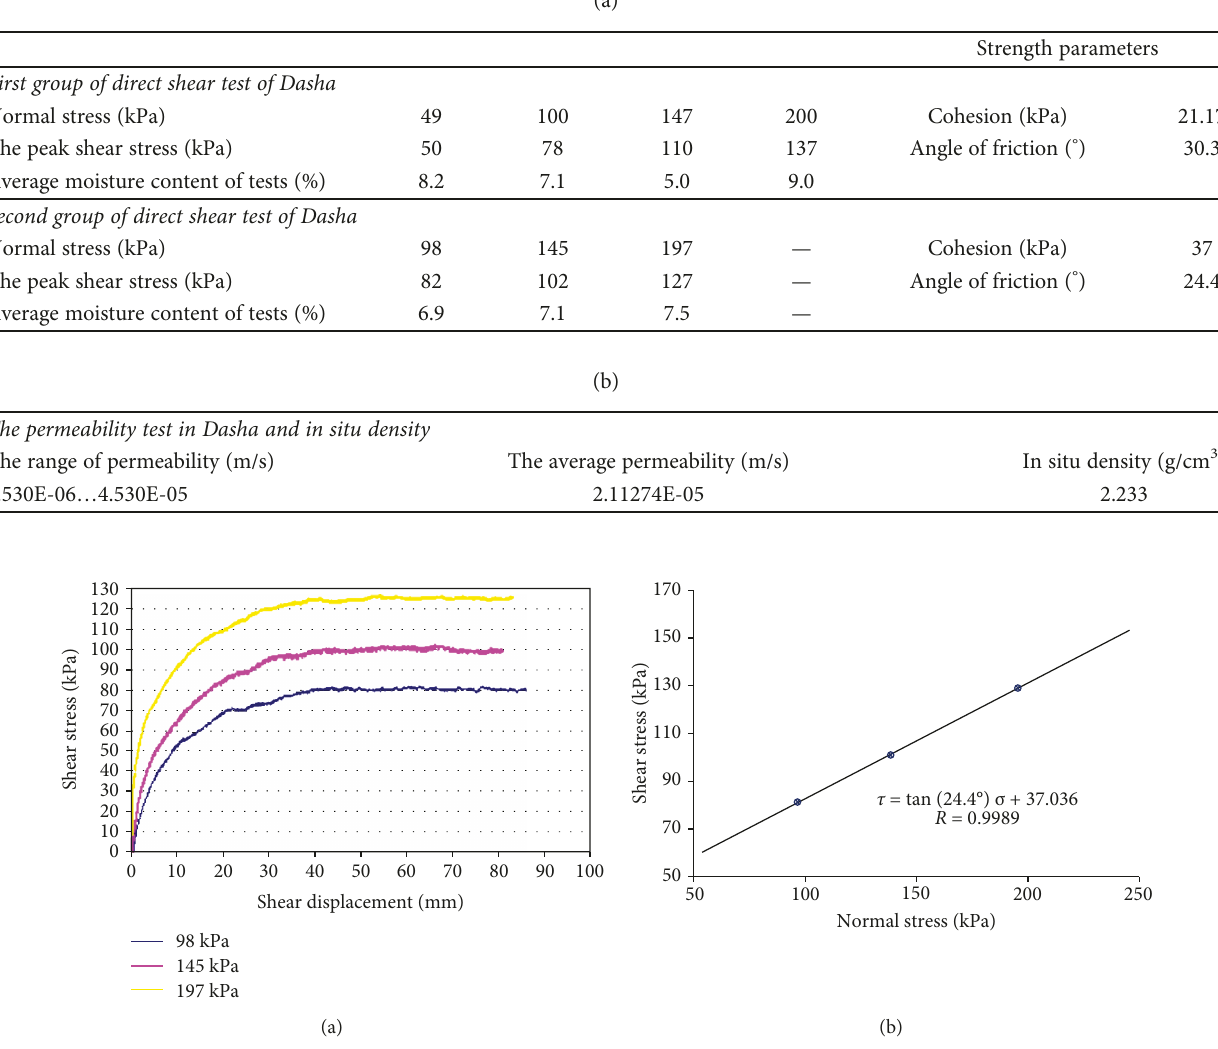
Figure 14: Shear stress - displacement curve and strength parameters of second group.